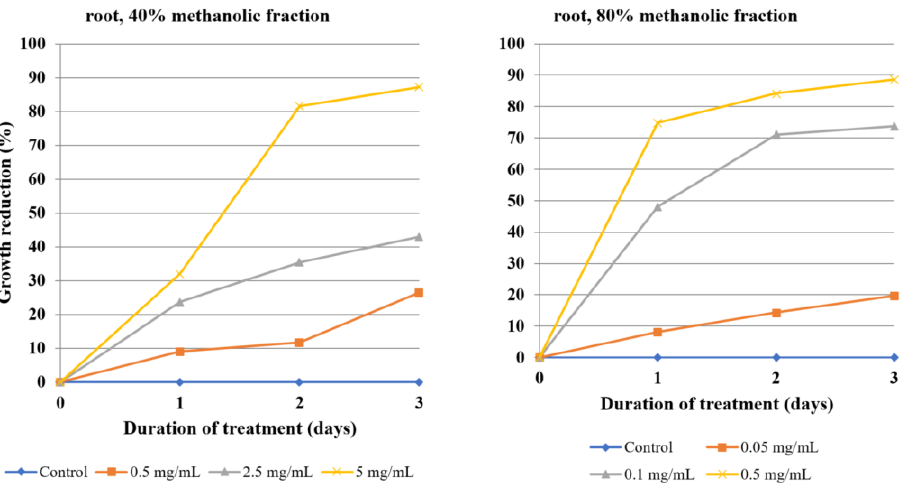
Figure 3. The effect of the 40% and 80% methanolic fractions of extract from the roots of Lychnis flos-cuculi on the inhibition of Acanthamoeba trophozoite proliferation in the culture medium.